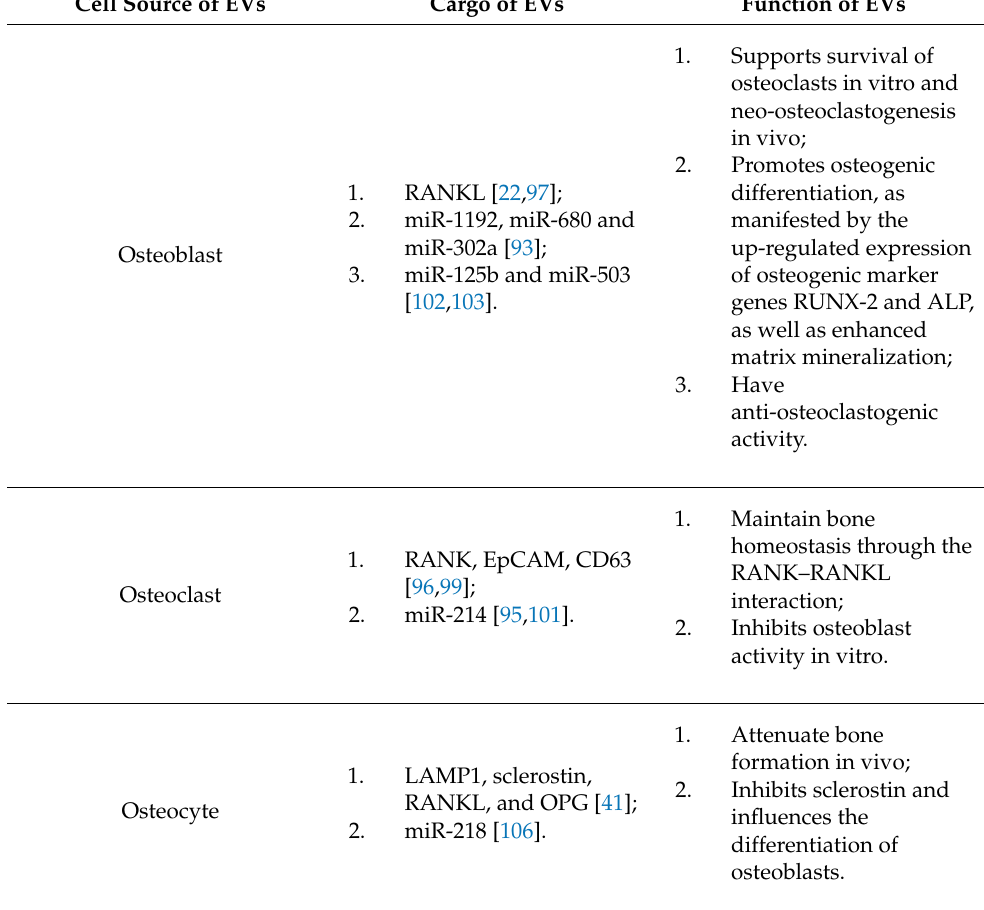
Table 1. Cargo and function of EVs derived from bone